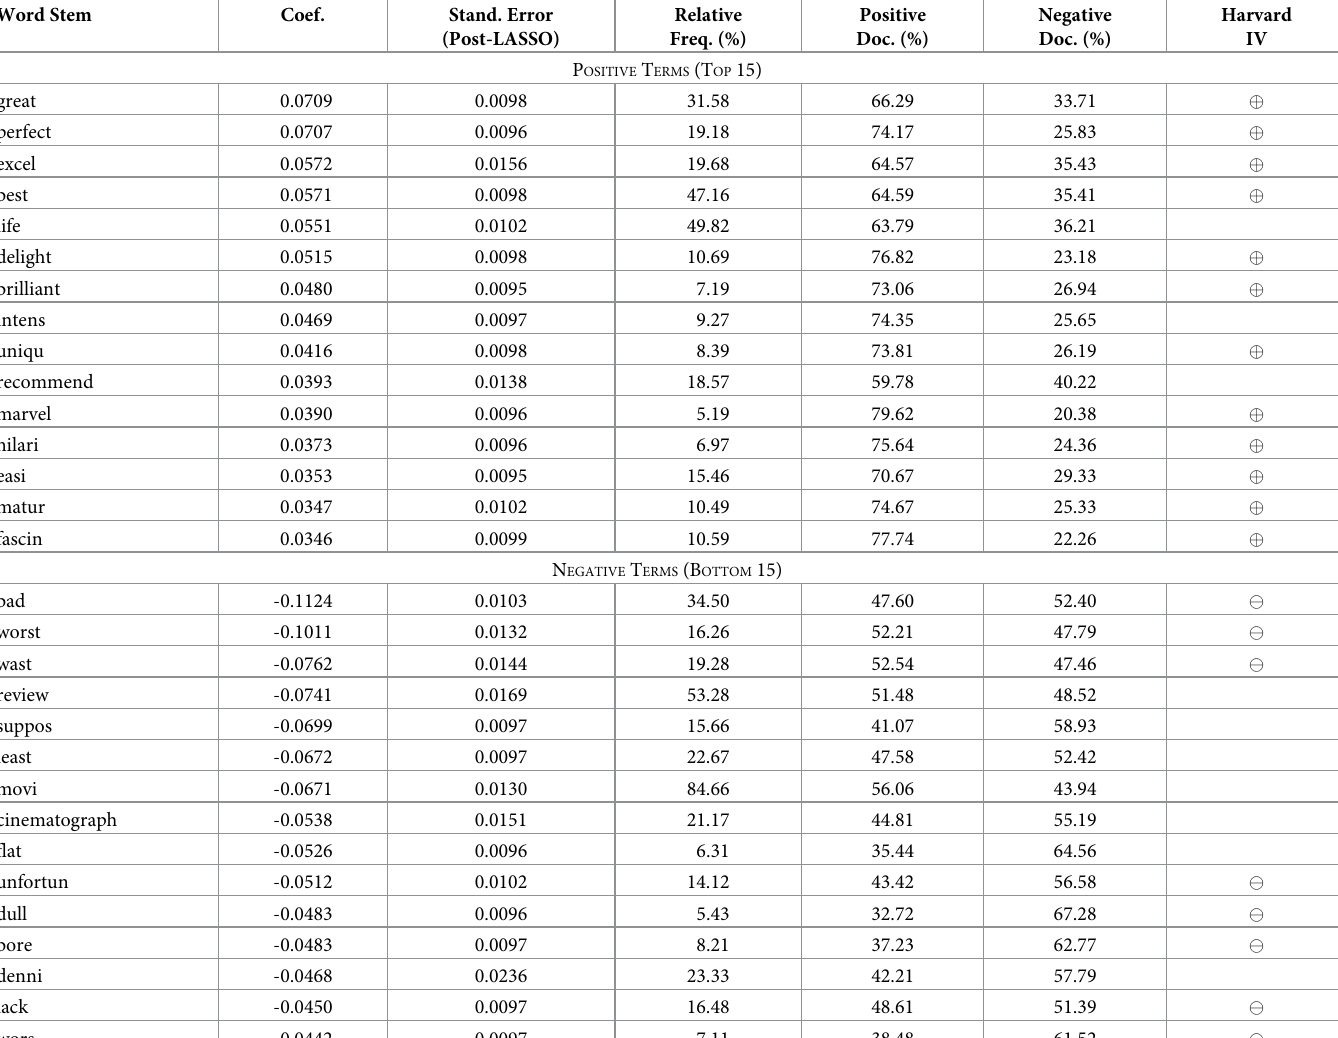
Table 2. Empirical results of top 15 opinionated terms in movie